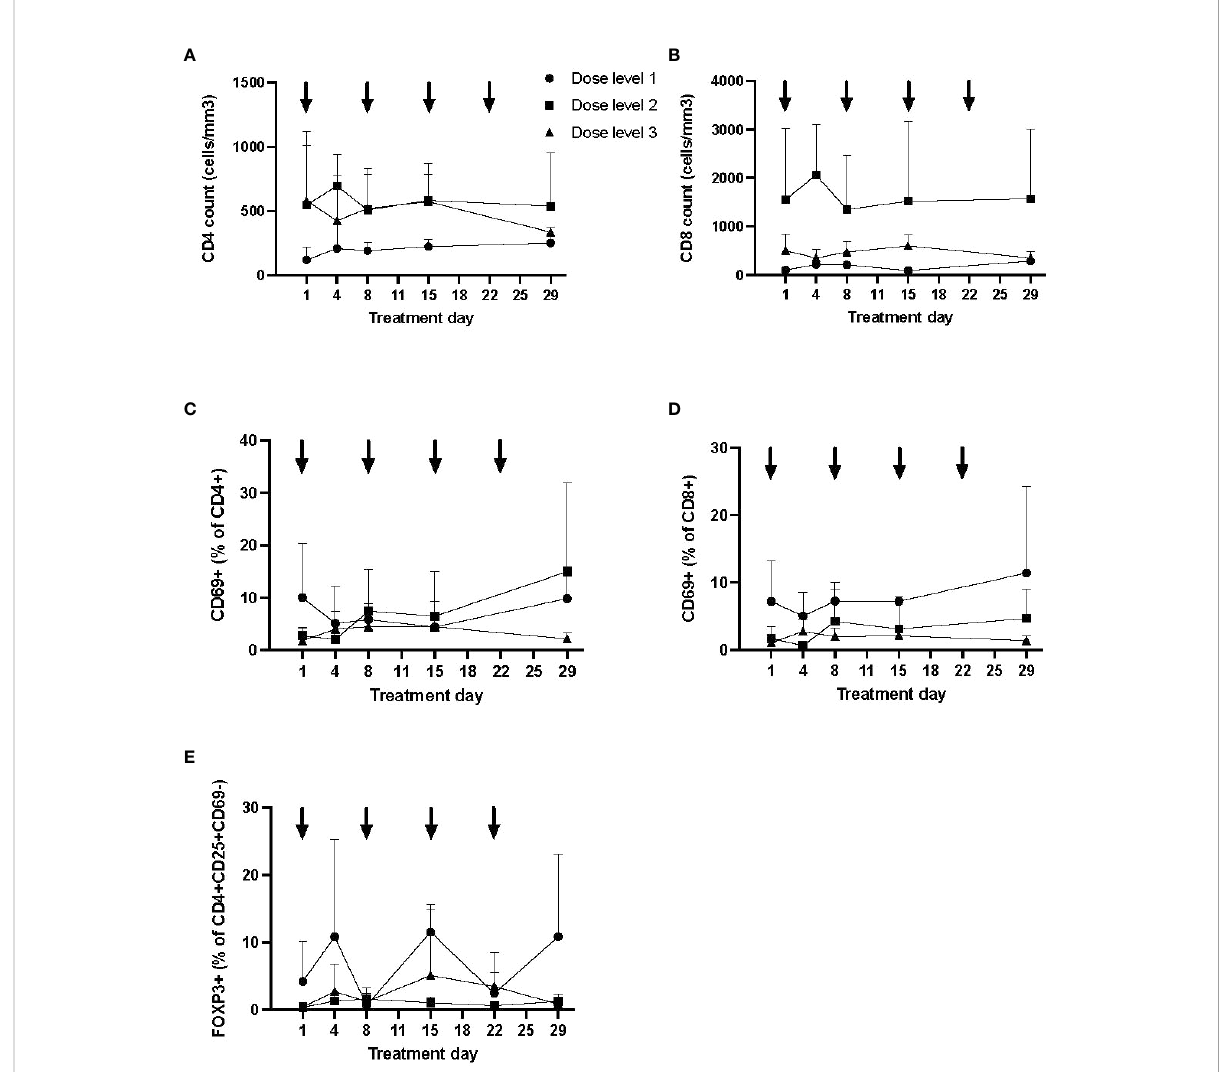
FIGURE 3 Longitudinal immune pro fi le following autologous MSC infusion. Flow cytometry was performed to evaluate lymphocyte subsets (CD3+CD4+ and CD3+CD8+; A , B ), T-cell activation (CD69+; C , D ), and regulatory T cells (E) longitudinally. Data (mean, SD) are shown by dose level, with timing of MSC infusion designated by arrows. The proportion of activated T cells was lowest at day 29 in dose level 3, although T-cell activation was higher at baseline in dose level 1. No signi fi cant differences were otherwise seen by dose level in T-cell counts or proportion of regulatory T cells. MSC, mesenchymal stromal cell; SD, standard